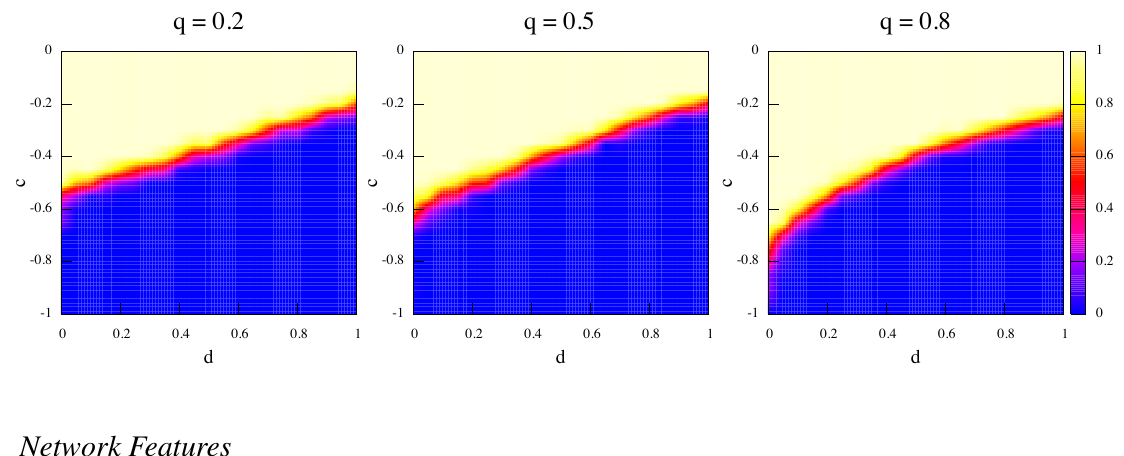
Figure 9. Average strategy proportions over 50 independent runs in the game’s phase space at steady state. Initially α players are 25% of the total. Update rule is replicator dynamics and rewiring frequency q increases from left to